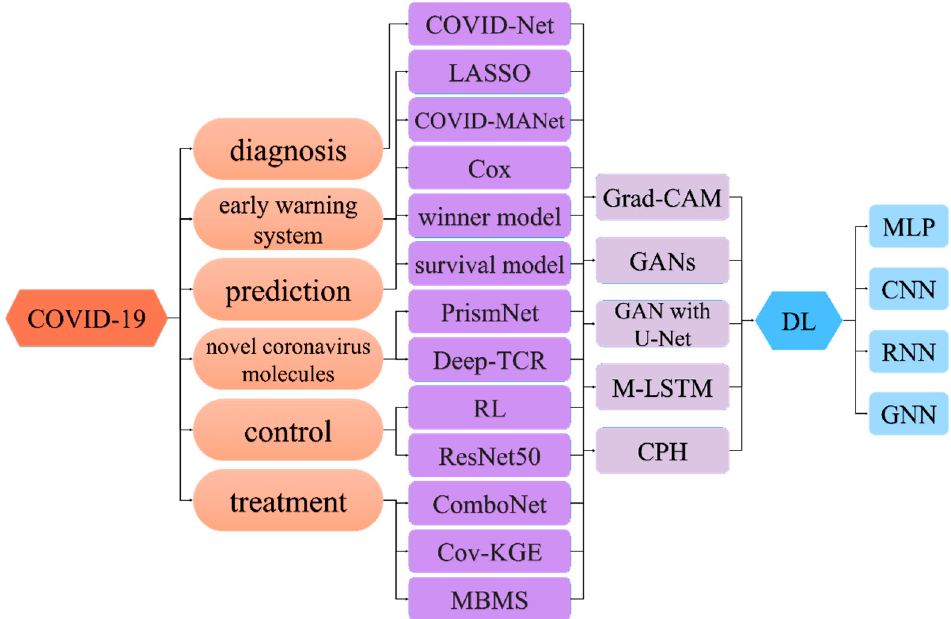
Figure 2. The deep-learning methods for COVID-19. LASSO: least absolute shrinkage and selection operator; RL: reinforcement learning; Cov-KGE: Coronavirus-knowledge graph embedding; MBMS: medication behavior monitoring system; Grad-CAM: Gradient-Weighted Class Activation Mapping; GANs: generative adversarial networks; M-LSTM: multivariate long short-term memory; CPH: the Cox proportional hazards model; DL: deep learning; MLP: a multilayer perceptron; CNN: convolutional neural network; RNN: recurrent neural network; GNN: graph neural network.